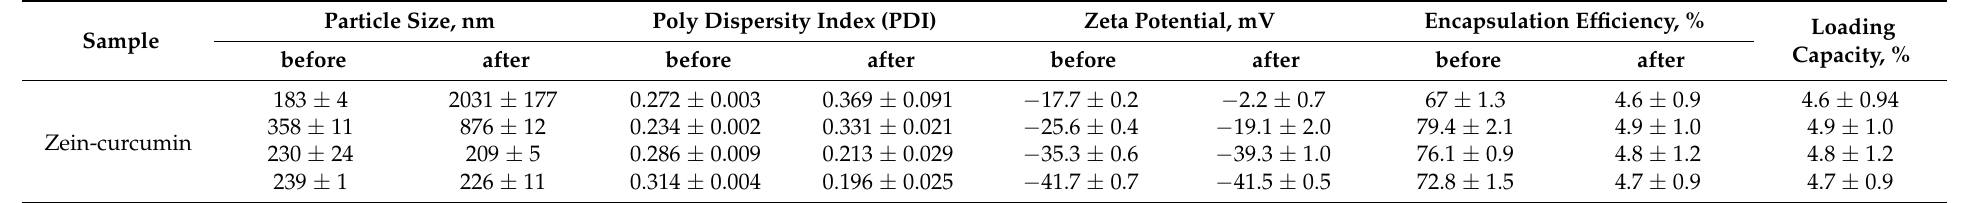
Table 3. Properties of zein nanoparticles and their ability to sorb curcumin. Reprinted with permission from ref. [60]. Copyright 2020 Elsevier.